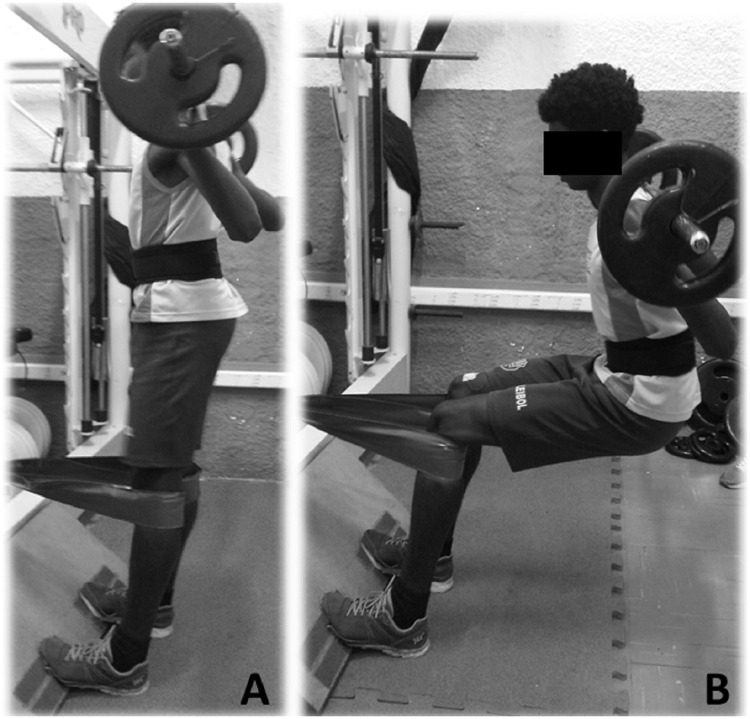
Half-squat exercise with eccentric emphasis performed with the Tirante Musculador®.A: Initial position of the movement; B: Final position of the movement.